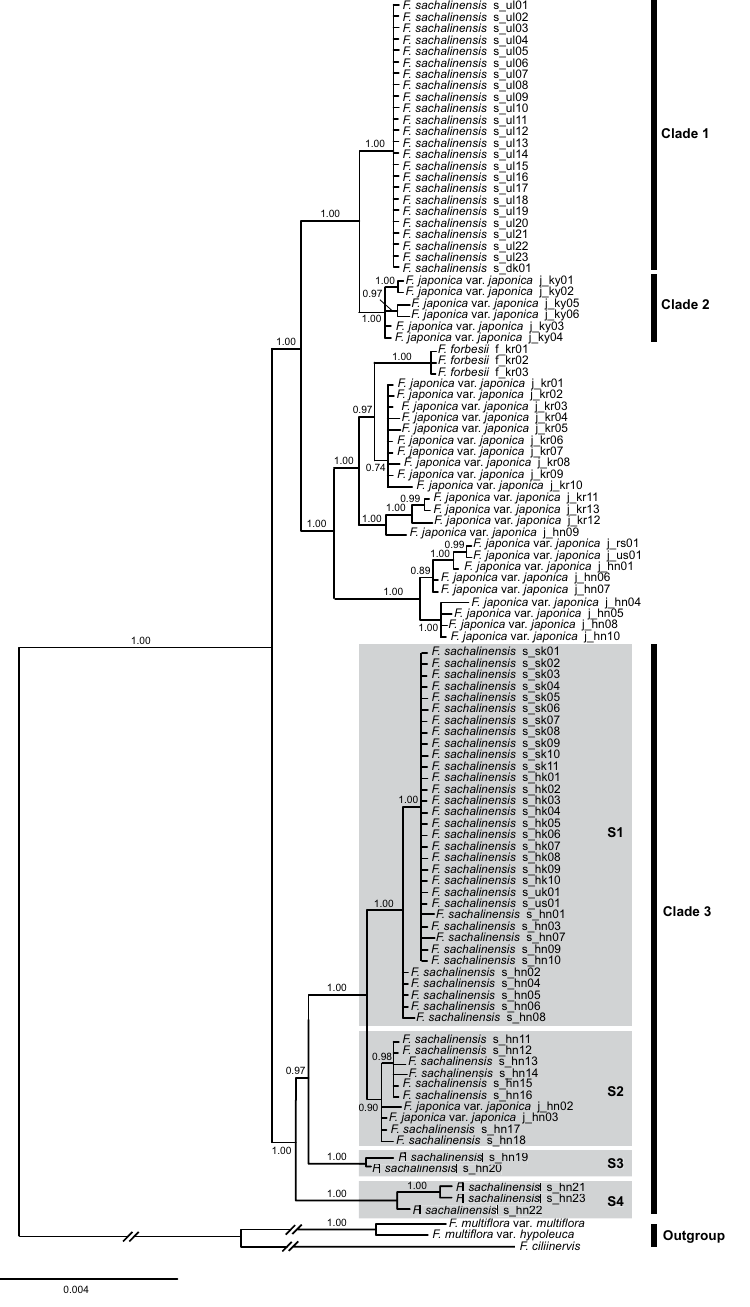
Figure 3. Bayesian majority-rule consensus tree for individuals of F. sachalinensis and closely related taxa based on the combined data set of eight cpDNA regions. Numbers above branches are Bayesian posterior probabilities (PP ≥ 0.7). Accession numbers correspond to those in Fig. 1 and Supplementary Table 1. Clade 1 comprises all accessions of F. sachalinensis from Ullung Island and Dok Island. Clade 2 is sister to Clade 1 and consists of F. japonica var. japonica accessions from Kyushu. Clade 3 comprises F. sachalinensis accessions from all other (non-Korean)